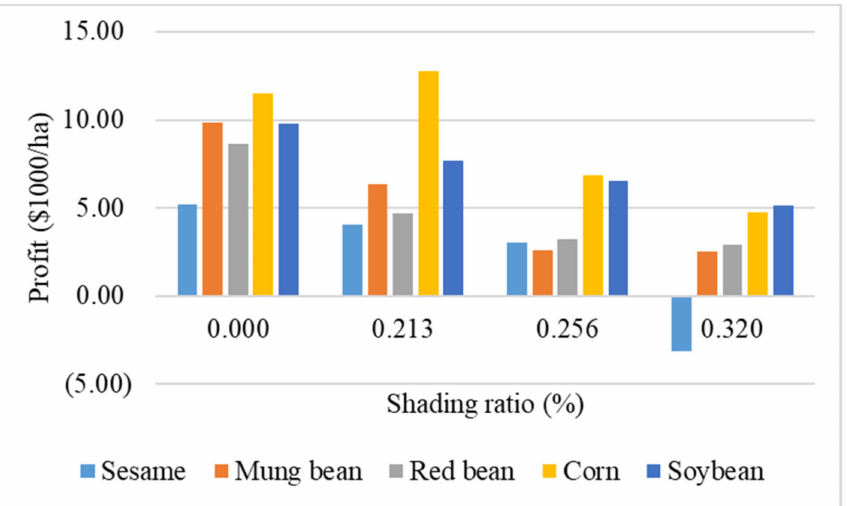
Figure 4. Estimated profits from five crops grown under four different shading levels (0, 21.3, 25.6, and